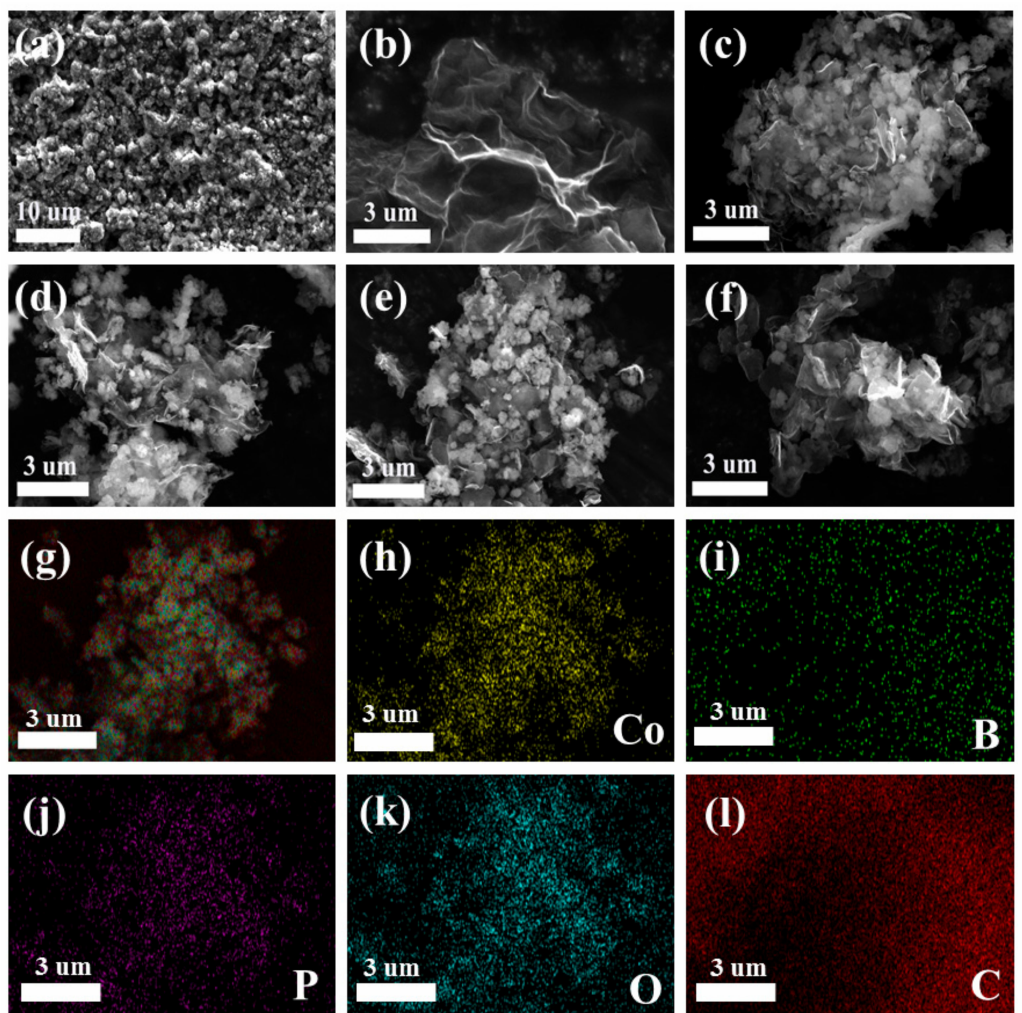
Figure 2. SEM images of ( a ) Co-B-P, ( b ) GO, ( c – f ) Co-B-P/xrGO (x = 25, 50, 75, and 100), and EDX mapping images of ( g ) Co-B-P/75rGO, ( h ) Co, ( i ) B, ( j ) P, ( k ) O, and ( l ) C in Co-B-P/xrGO.